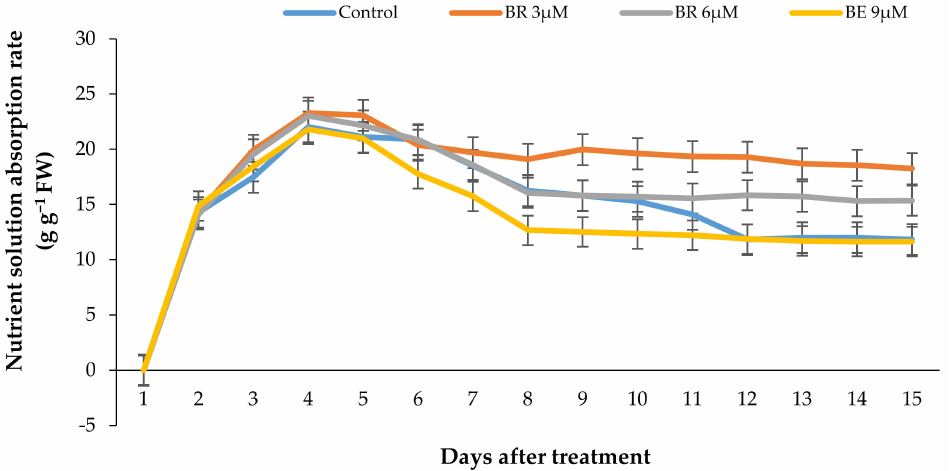
Figure 8. Effect of different EBL concentrations on the vase solution absorption pattern in lisianthus cut flowers in response to the EBL treatment during 15 days of keeping at room temperature. Error bars represent the standard error of means of four